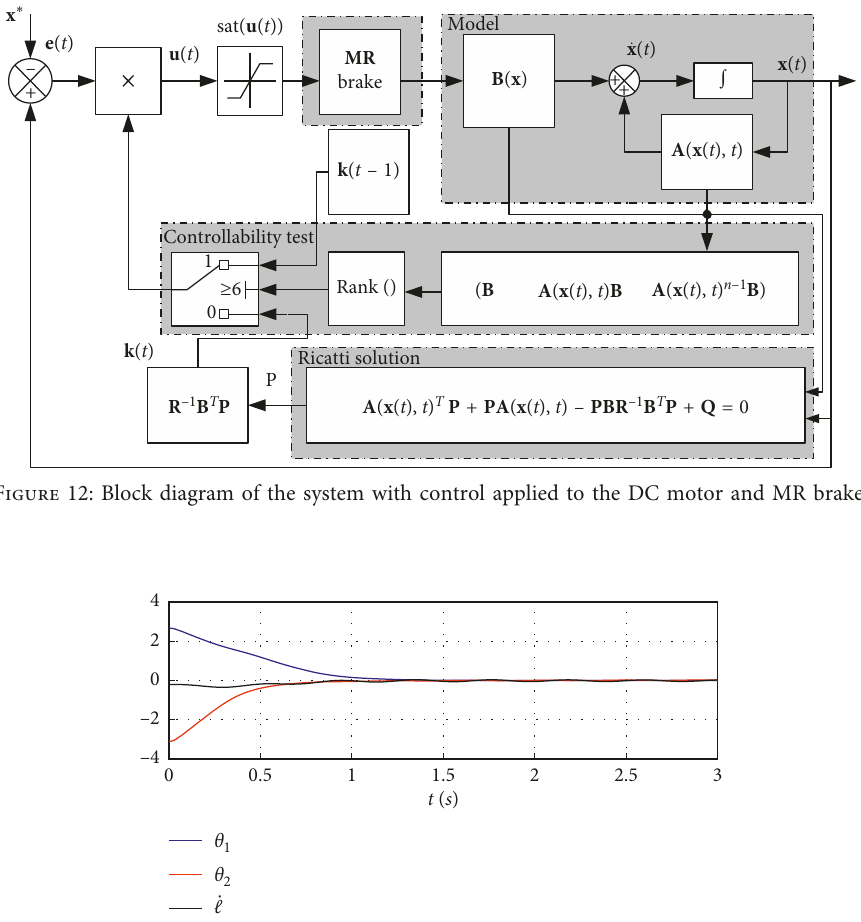
Figure 13: Positioning error response for nonideal loading manipulator with DC motor and MR brake.